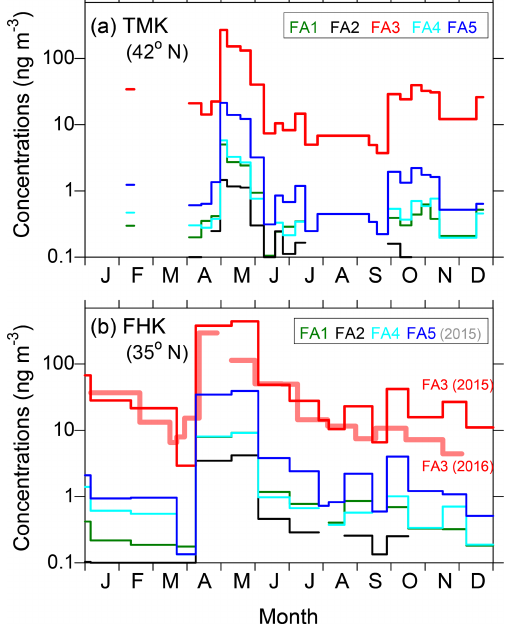
Figure 4. Temporal variations in the mass concentrations of the fatty alcohols (FAs) in the TSP samples at (a) TMK and (b) FHK sites in 2015. FA1: n -heptacosan-10-ol, FA2: n -heptacosan-5,10- diol, FA3: n -nonacosan-10-ol, FA4: n -nonacosan-10,13-diol, and FA5: n -nonacosan-5-10-diol. The data of FA3 in 2016 are also shown for